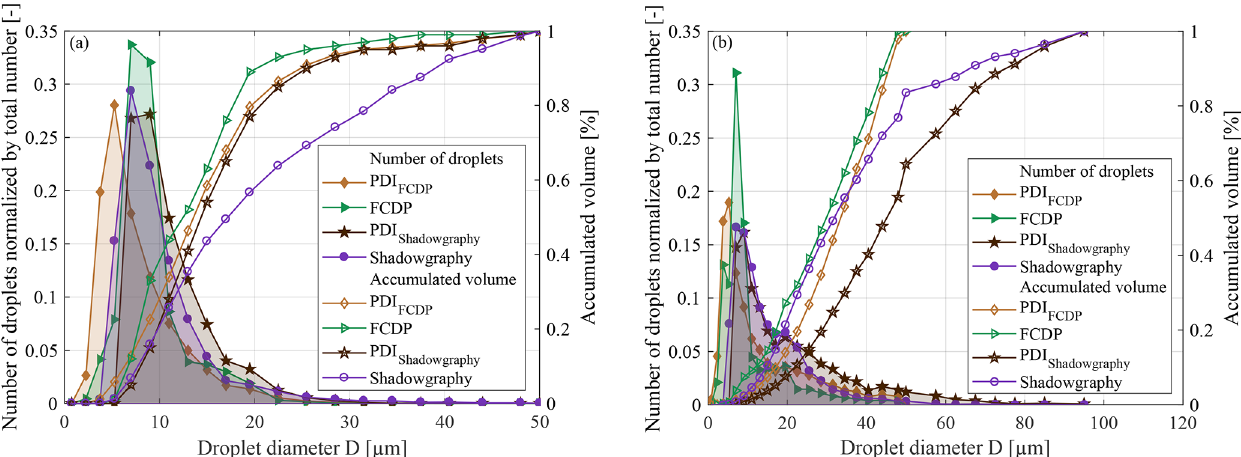
Figure 9. Droplet size distribution of different methods ( a : MVD 14.5µm; b : MVD 33.8µm).